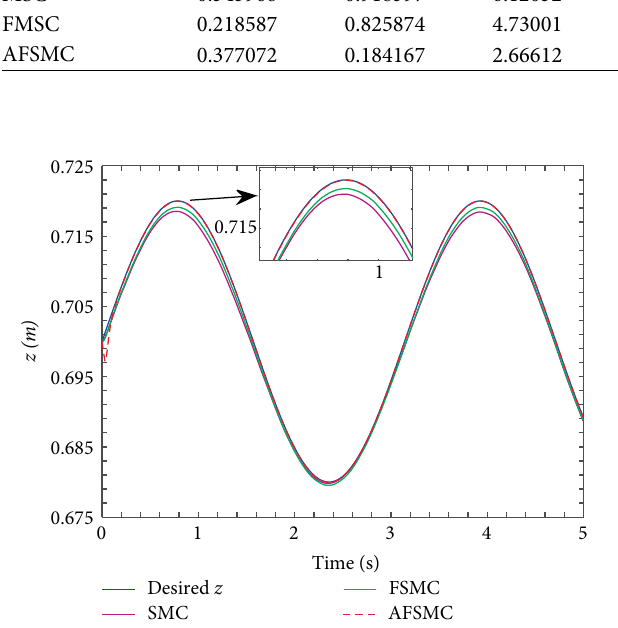
Figure 12: Trajectory tracking about rotation angle controllers.